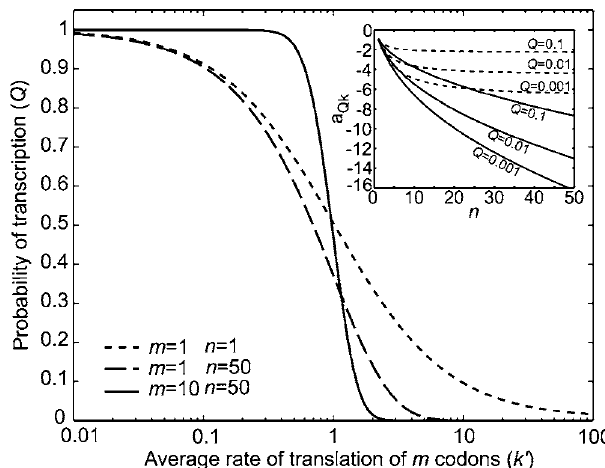
Figure 2. The Probability Q of Read-Through of the Attenuation Leader Is Plotted as a Function of k 9 ¼ 1 / s Where s Is the Average Time for Translation of All the m Codons The translation rates of the individual codons are k ¼ k 9 (cid:2) m . The average time to transcribe the n nucleotides is kept constant at 1/ q 9 ¼ 1 s . The transcription rate for an individual nucleotide is q ¼ q 9 (cid:2) n . For m ¼ 1, n ¼ 1 the response function is given by Equation 6; for m ¼ 1, n ¼ 50 the response function is given by Equation 8. These curves should be compared to the much more sensitive response that is reached with two competing multi-step processes, as in attenuation (e.g., m ¼ 10, n ¼ 50). Insert: The sensitivity amplification a Qk is plotted as a function of n, while k is kept fixed, and q is changed to get the read-through probabilities (Q) corresponding to the different curves. The two curve families correspond to the ordinary multi-step mechanism with m ¼ 1 (dashed) and the competing multi-step mechanisms with m ¼ n (solid), respectively. The dashed curves approach ln( Q ) as n ! ‘ , whereas the solid curves all go to (cid:1) ‘ for all values of Q . DOI: